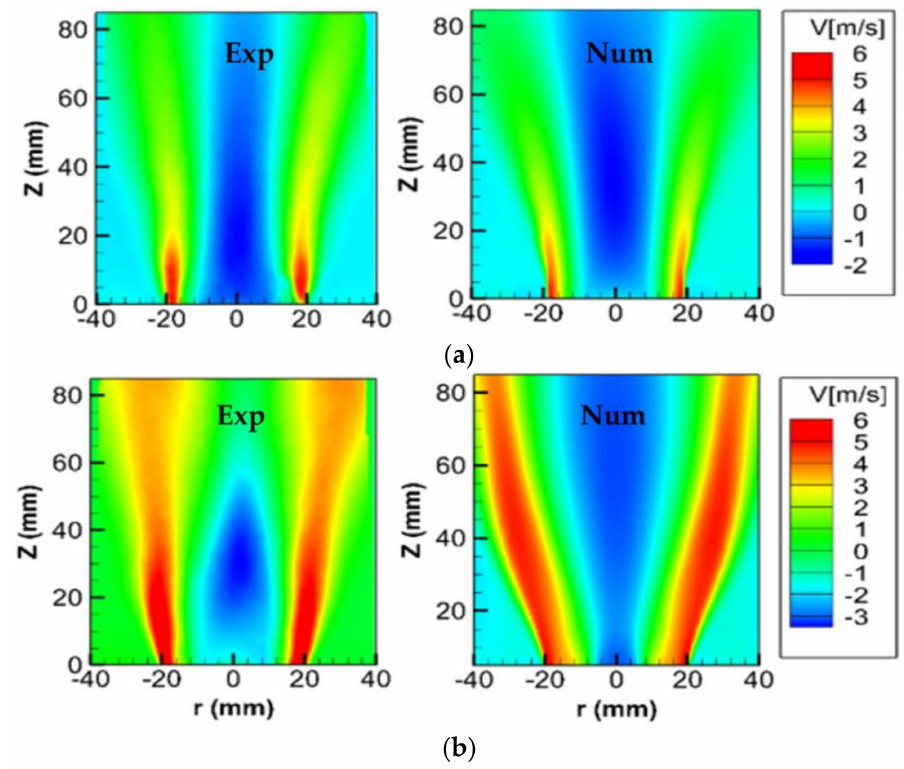
Figure 4. Numerical and experimental contours of mean axial velocity under non-reacting and reacting cases; ( a ) non − reacting case; ( b ) reacting